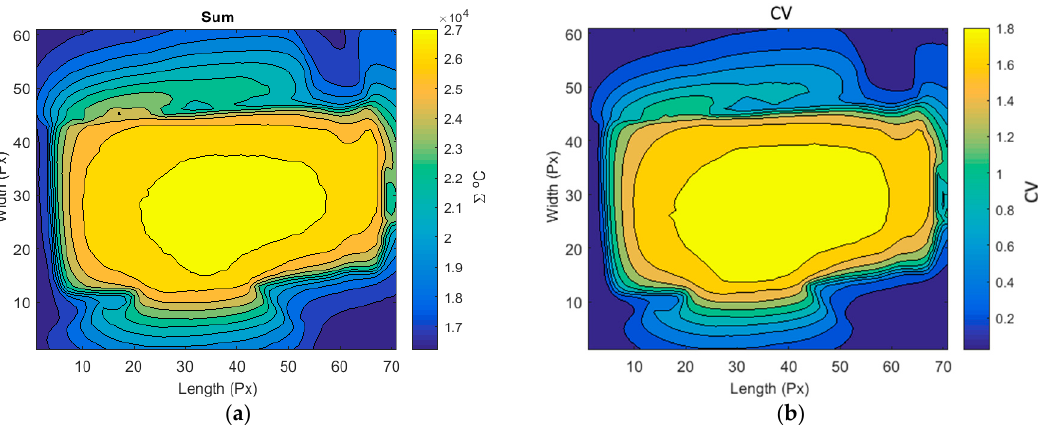
Figure 17. ( a ) Image of sum of temperatures ( Σ T ); ( b ) Image of the coefficient of variation ( CV ).